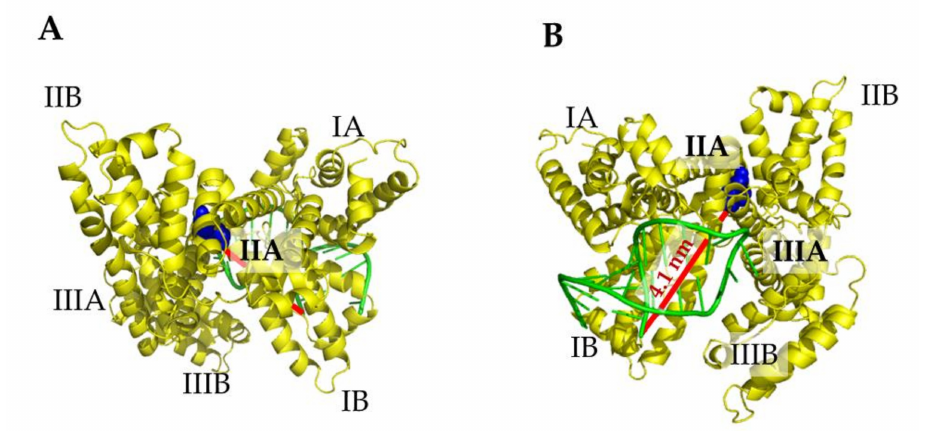
Figure 7. Front ( A ) and back ( B ) view of a graphical representation of the best model (Model 1) for the complex between HSA (yellow) and miR4749 (green). The distance D DA between Trp146 and the 5 (cid:48) end of miR4749 and the center of the aromatic rings of the lateral chain of Trp214 of HSA (red line) is reported. The regions of HSA are labelled and Trp214 is shown as blue